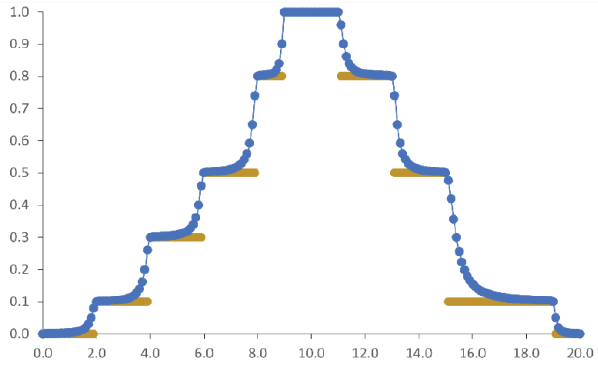
Figure 4. Multiple sinusoidal membership functions fitted within an AHP membership function— Nested Fuzzy